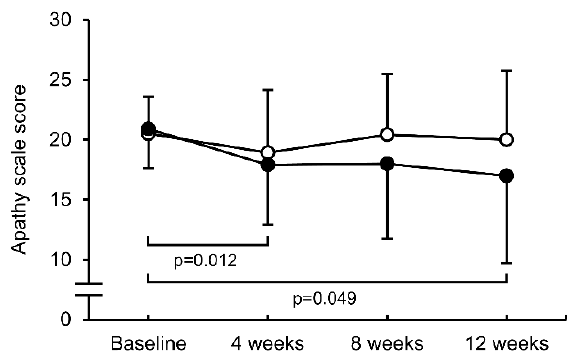
Figure 2. Changes in apathy scale score after 4, 8, and 12 weeks of treatment. Data are expressed as mean ± standard deviation. Closed circle: Group A, open circle: group B.